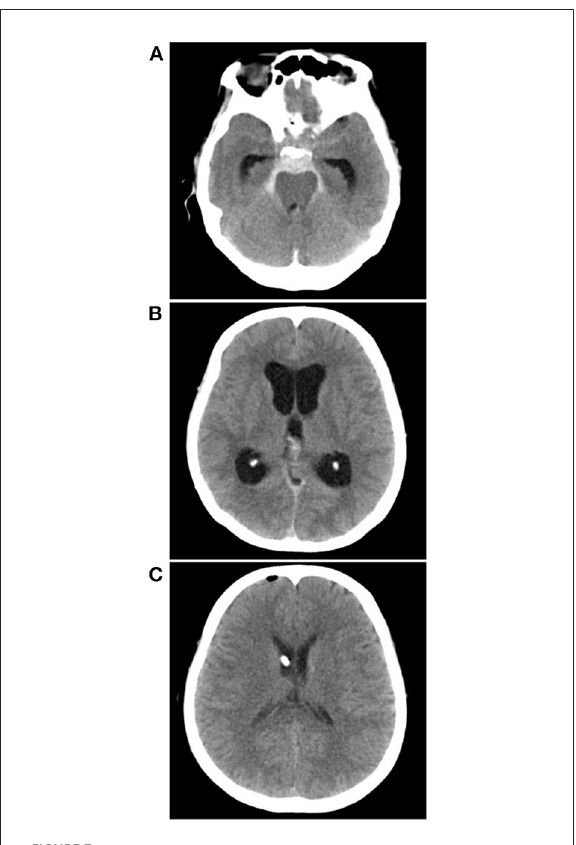
FIGURE7 External ventricle drainage in a PNSAH. (A) CT showing a classic PNSAH. (B) CT showing acute lateral ventricle dilation. (C) CT showing the normal size of lateral ventricle after external ventricle drainage. CT, computed tomography; PNSAH, perimesencephalic non-aneurysmal subarachnoid